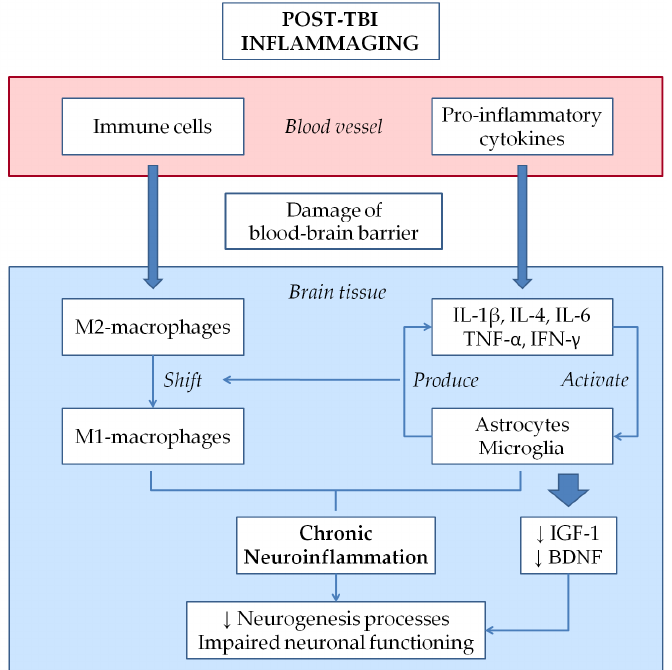
Figure 2. Mechanism of post-TBI inflammaging. Vascular damage caused by inflammatory molecules leads to extravasation of immune cells and pro-inflammatory cytokines into the brain tissue. These components are able to activate astrocytes and microglia, which produce further pro-inflammatory cytokines. In this setting, macrophages shift from the protective M2 phenotype towards the pro-inflammatory M1 phenotype. The consequent chronic neuroinflammation together with the decreased production of neurotrophic factors (IGF-1 and BDNF) lead to impaired neuronal functioning and neurogenesis processes.